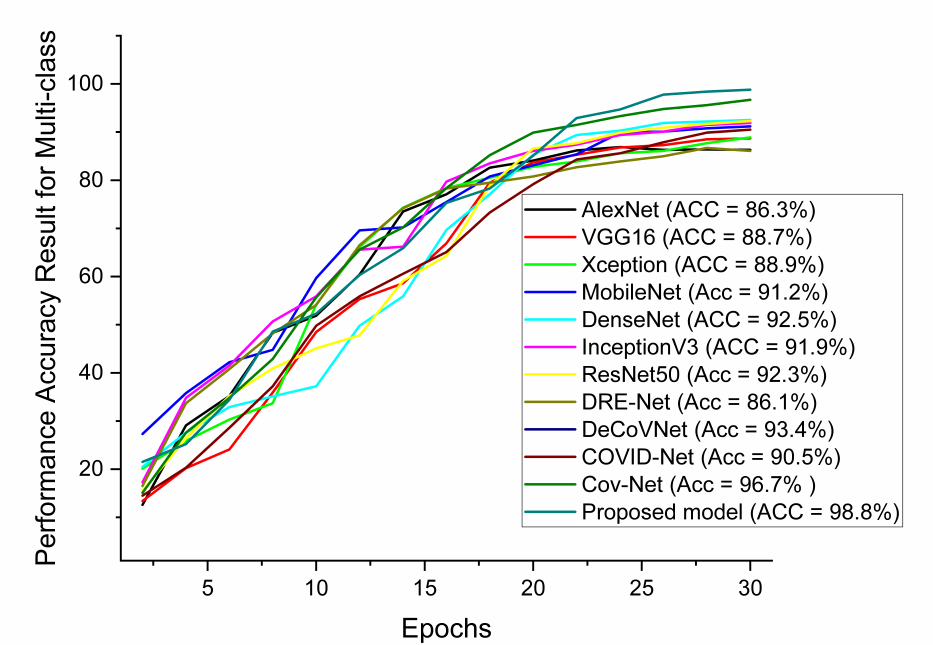
Figure 12. Performance accuracy in comparison with our proposed model and other pre-trained models and selected state-of-the-art COVID-19 models for